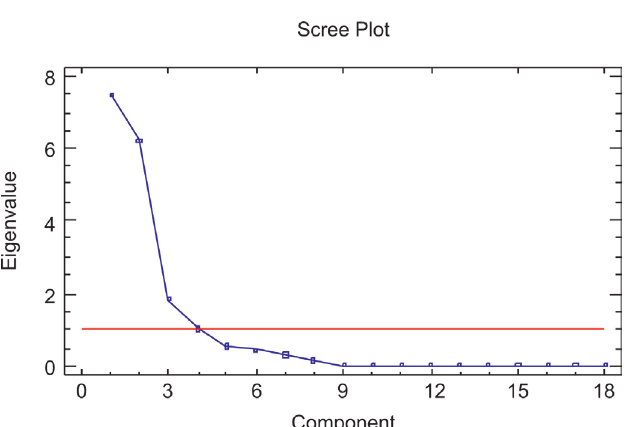
FIGURE 2 - Eigenvalues obtained from the 18 total components. T he red line indicates the 4 principal